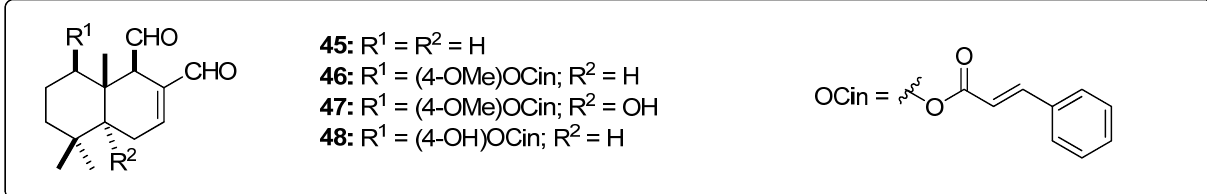
Figure 3. Structures of the tested drimane sesquiterpenes [24].